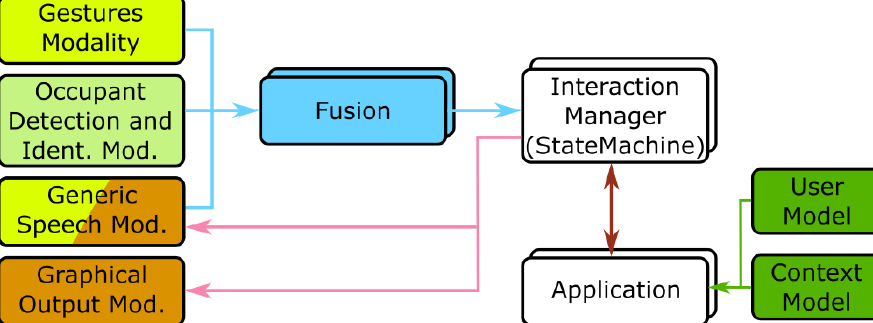
Figure 3. Diagram depicting the modules included in a first instantiation of the AM4I architecture for Smart Environments: the AM4I Framework. Multiple instances of each module can